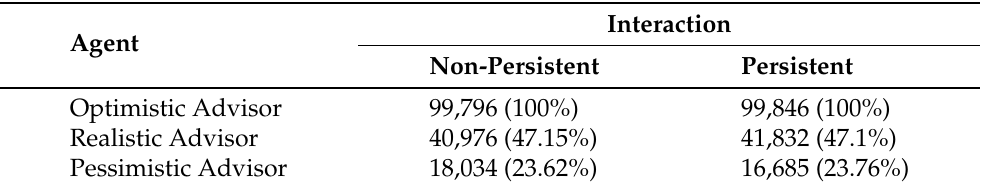
Table 2. The average number of interactions in the experiment for each kind of agent and the percent compared with the total steps